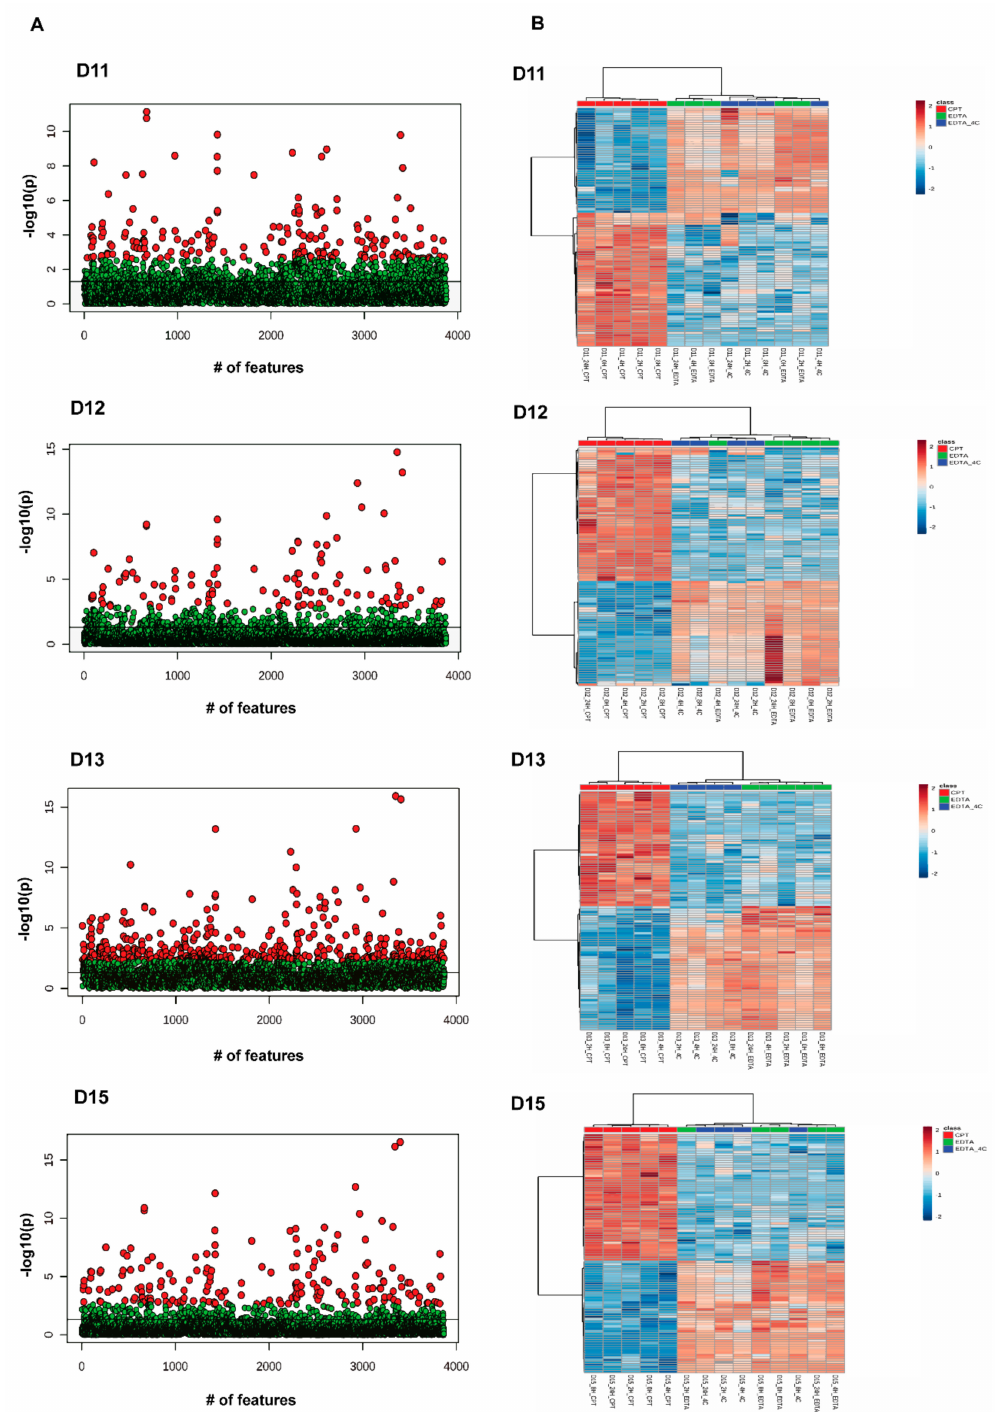
Figure 4. One-way ANOVA analysis of donor-matched lipidomics data. ( A ) Scatterplot showing One-way analysis of variance among donor-matched samples grouped by anticoagulants (red dots show p -value < 0.05). ( B ) Two-way hierarchical clustering analysis using Euclidean distance and ward.D clustering algorithm among donor-matched samples grouped by anticoagulants. The heatmap shows the top 100 lipid species that are di ff erent between CPT and EDTA containing tubes. Note: The Y -axis scale of scatter plot is automatically adjusted by Metaboanalyst based on the range of − log10(p). The line on the scatter plot demarcates the − log10(0.05) value on Y